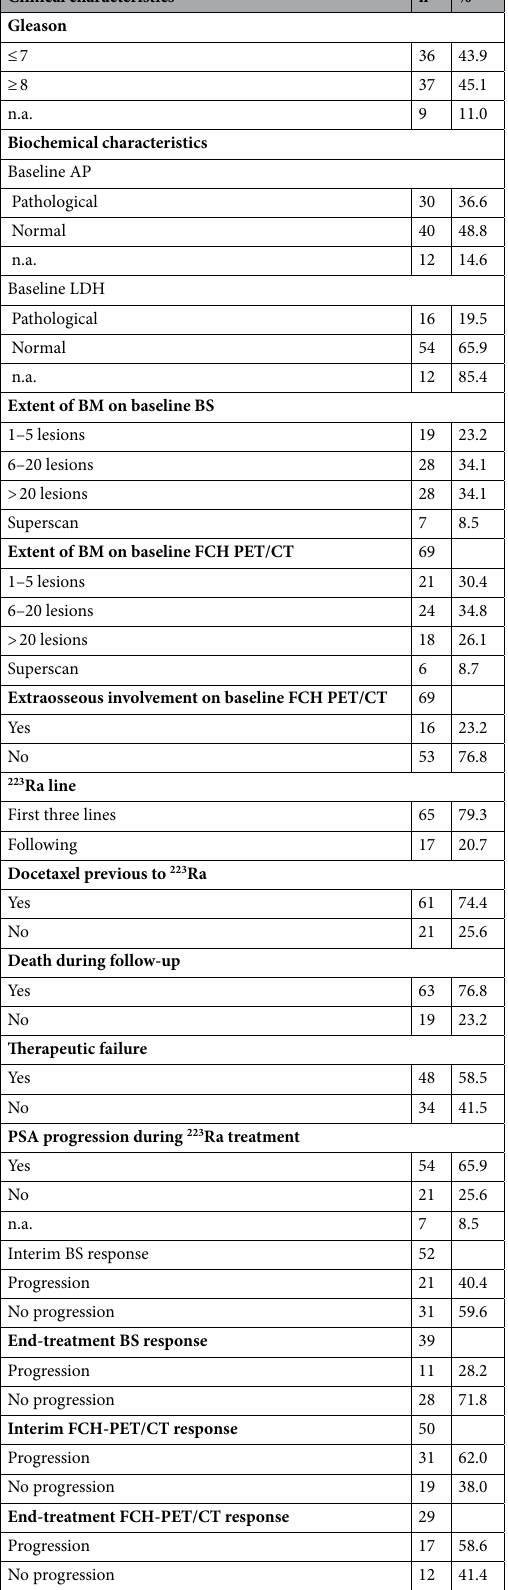
Table 2. Patients and tumour characteristics (qualitative and categorical variables). AP alkaline phosphatase, LDH lactate dehydrogenase, n.a . not available, n number of patients, BM bone metastases, BS bone